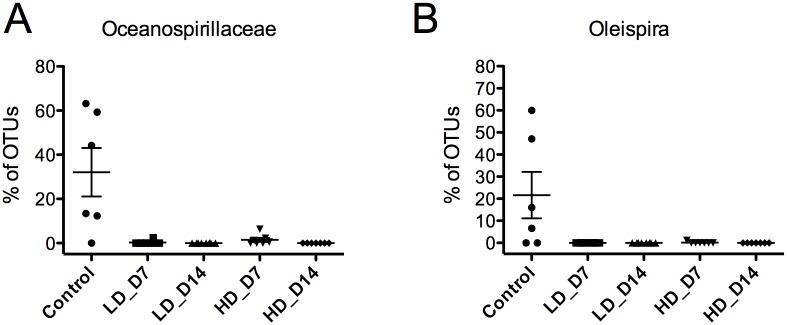
SAV3 infection results in losses of beneficial bacteria in Atlantic salmon skin.Percentage of total OTUs respresented by Oceanospirillaceae (A) and Oleispira sp. (B) in control and SAV-infected groups. The P values obtained in the statistical analysis are shown in Table 2. LD_D7: low-dose infected day 7; LD_D14: low-dose infected day 14; HD_D7: high-dose infected day 7; HD_D14: high-dose infected day 14.